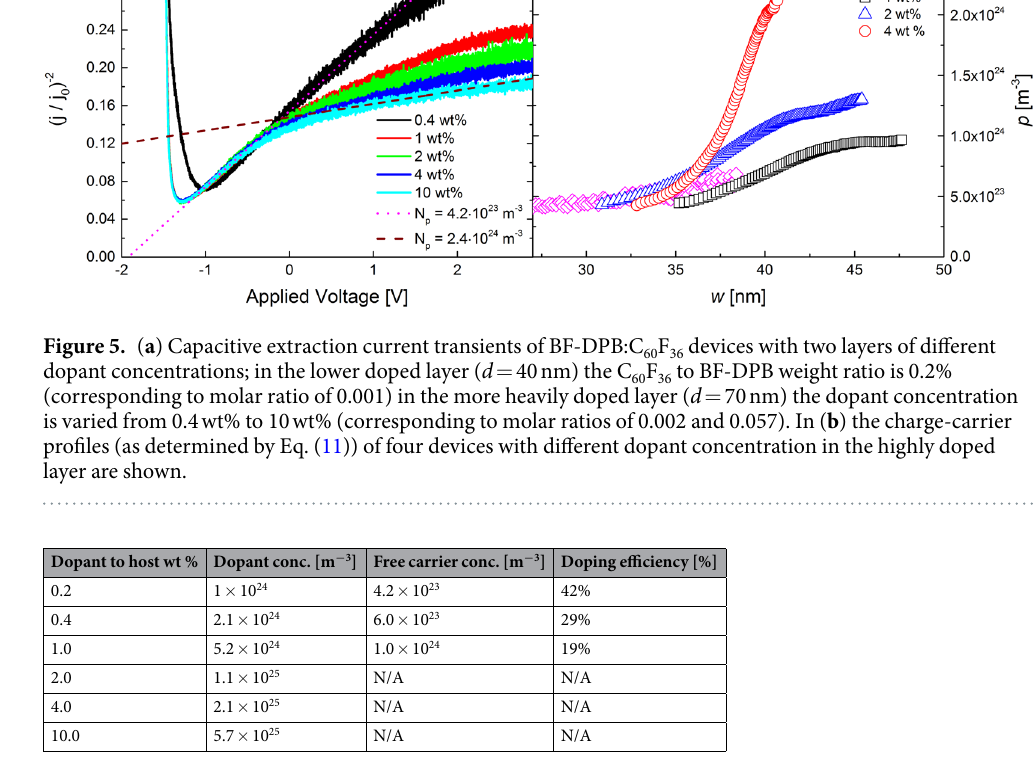
Table 1. The dopant to host weight % (wt %), dopant concentration, measured free-carrier concentration, and doping efficiency of the doped layers